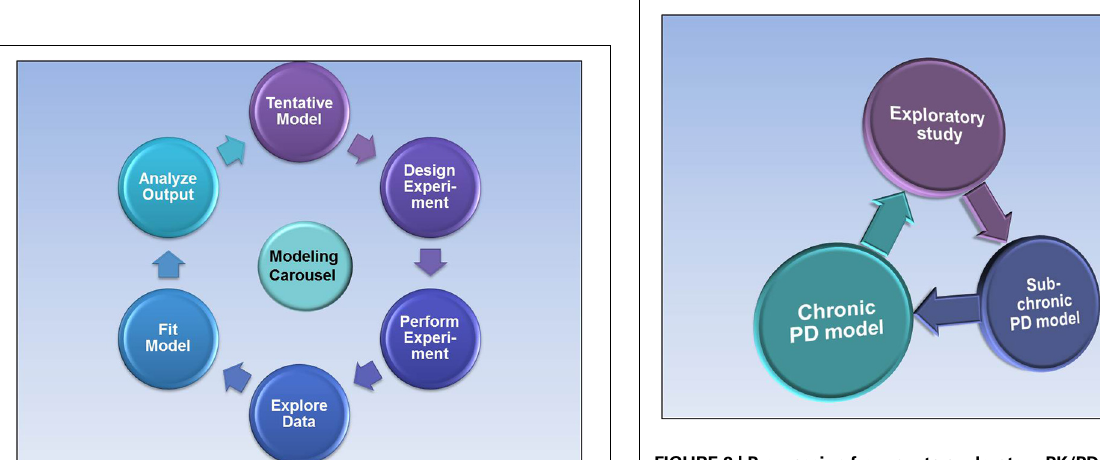
FIGURE 2 | Progression from acute exploratory PK/PD studies to subchronic and chronic PK/PD studies as drug candidates are identified and